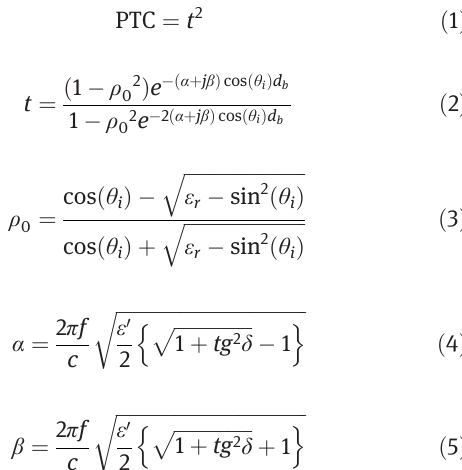
Table 1: Complex permittivities of mullite and Al 2 O 3 at 915/2,450 MHz. Parameters